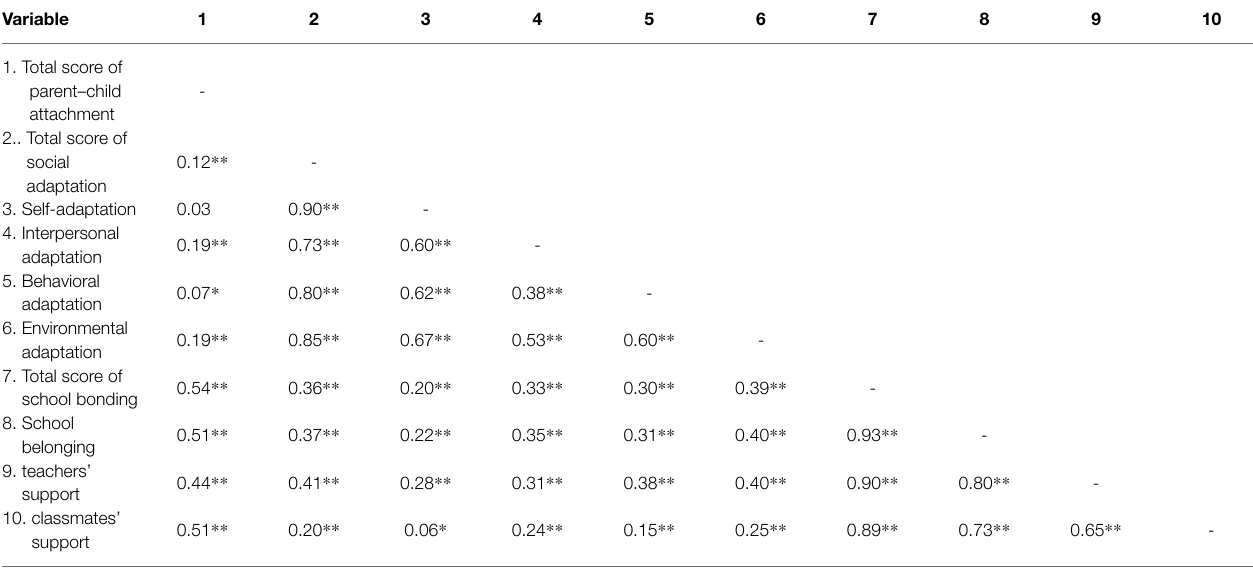
TABLE 3 | Correlations between parent-child attachment and the dimensions of social adaptation and school bonding ( N = 1,320). Variable